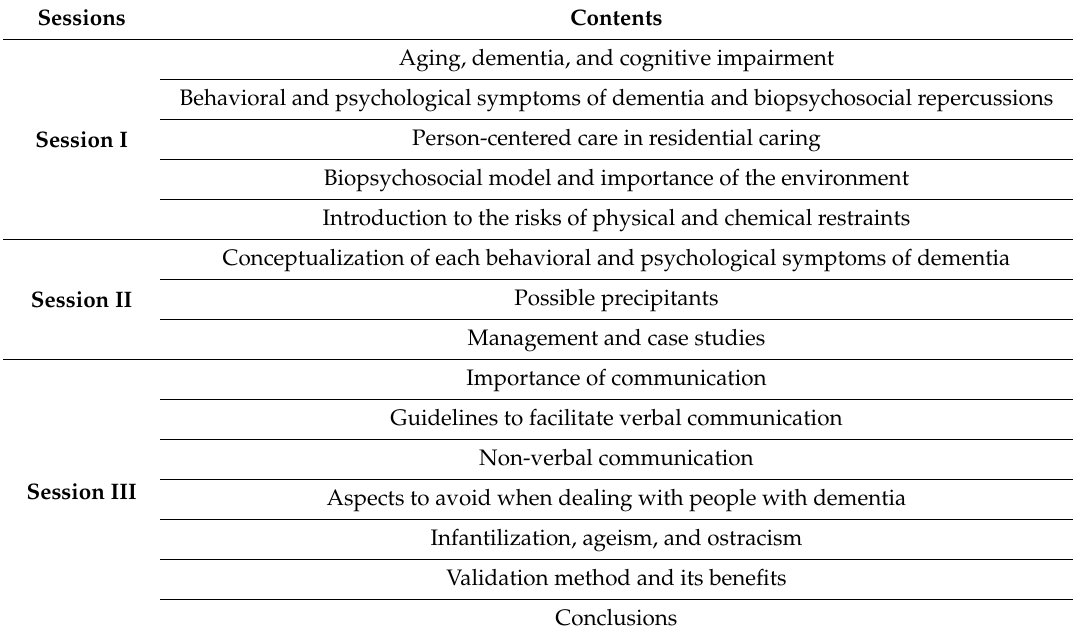
Table 1. Educational program